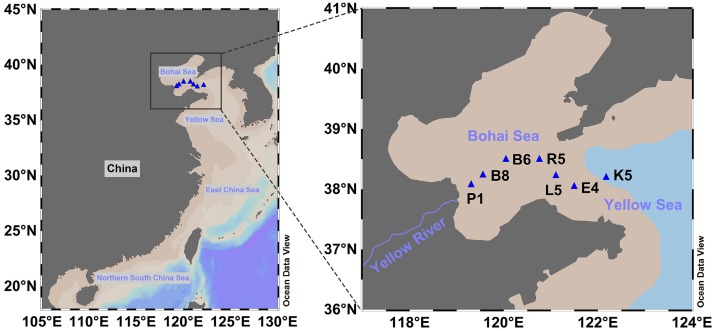
The map of sampling sites in this study.